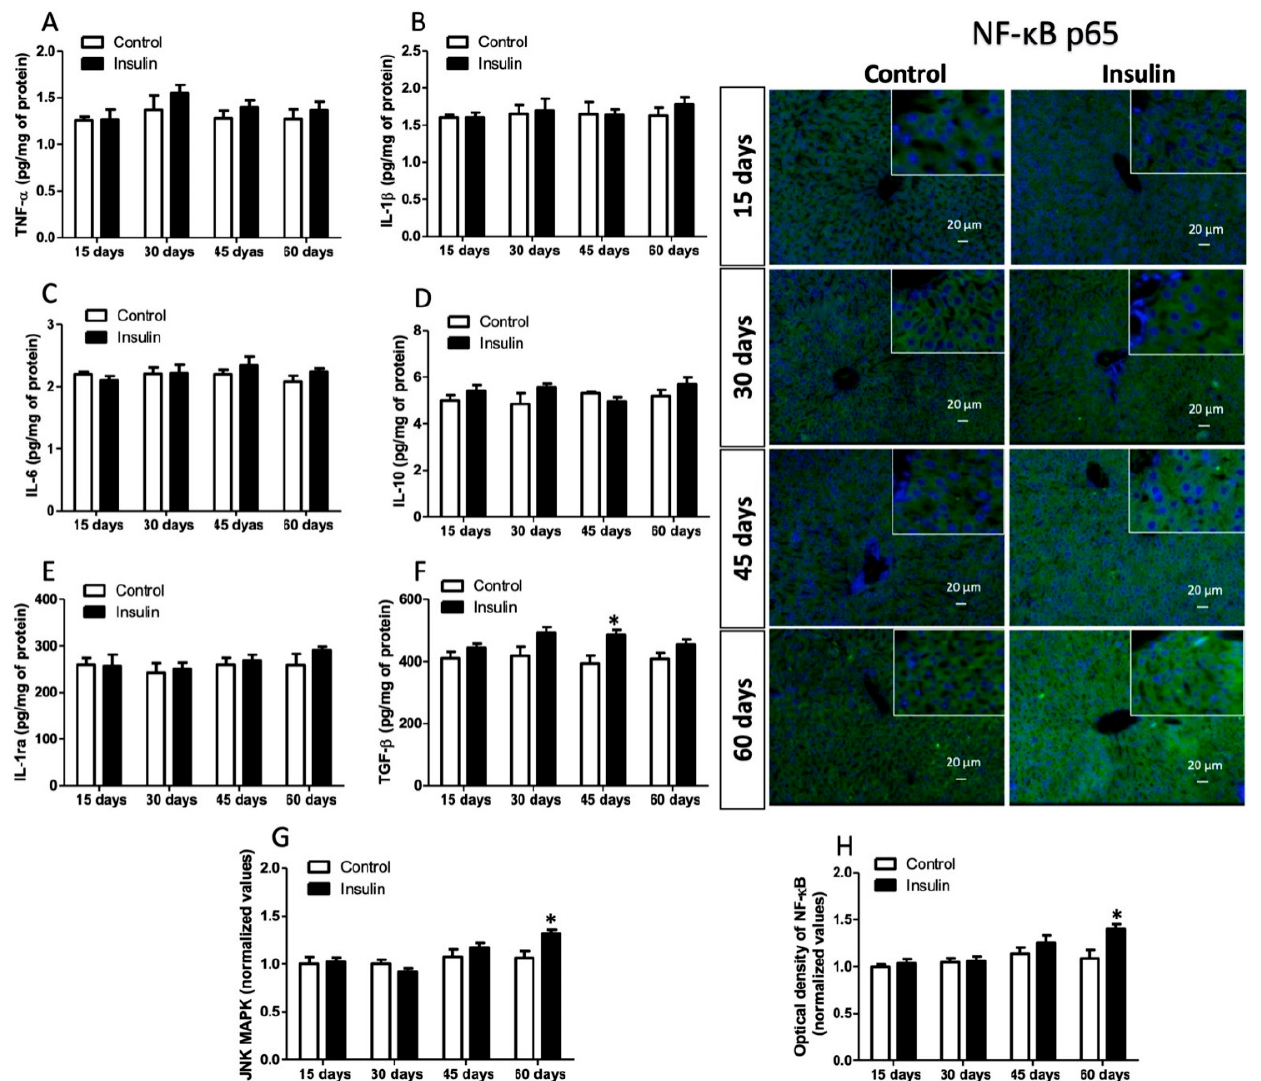
Figure 6. Hepatic inflammation status. ( A ) TNF- α ; ( B ) IL-1 β ; ( C ) IL-6; ( D ) IL-10; ( E ) IL-1Ra; ( F ) TGF- β ; ( G ) JNK-MAPK level; ( H ) NF- κ B (p65) immunoreactivity. Results are the mean average of 10 separate experimental animals per group ± SEM. (*) Indicates a significant difference compared to the control groups ( p ≤ 0.05). Figures ( A – F ) were analyzed by the Student’s t -test, and figures ( G , H ) were analyzed by the Mann–Whitney U test. The scale bar corresponds to 20 µ m in a magnification of 400 ×